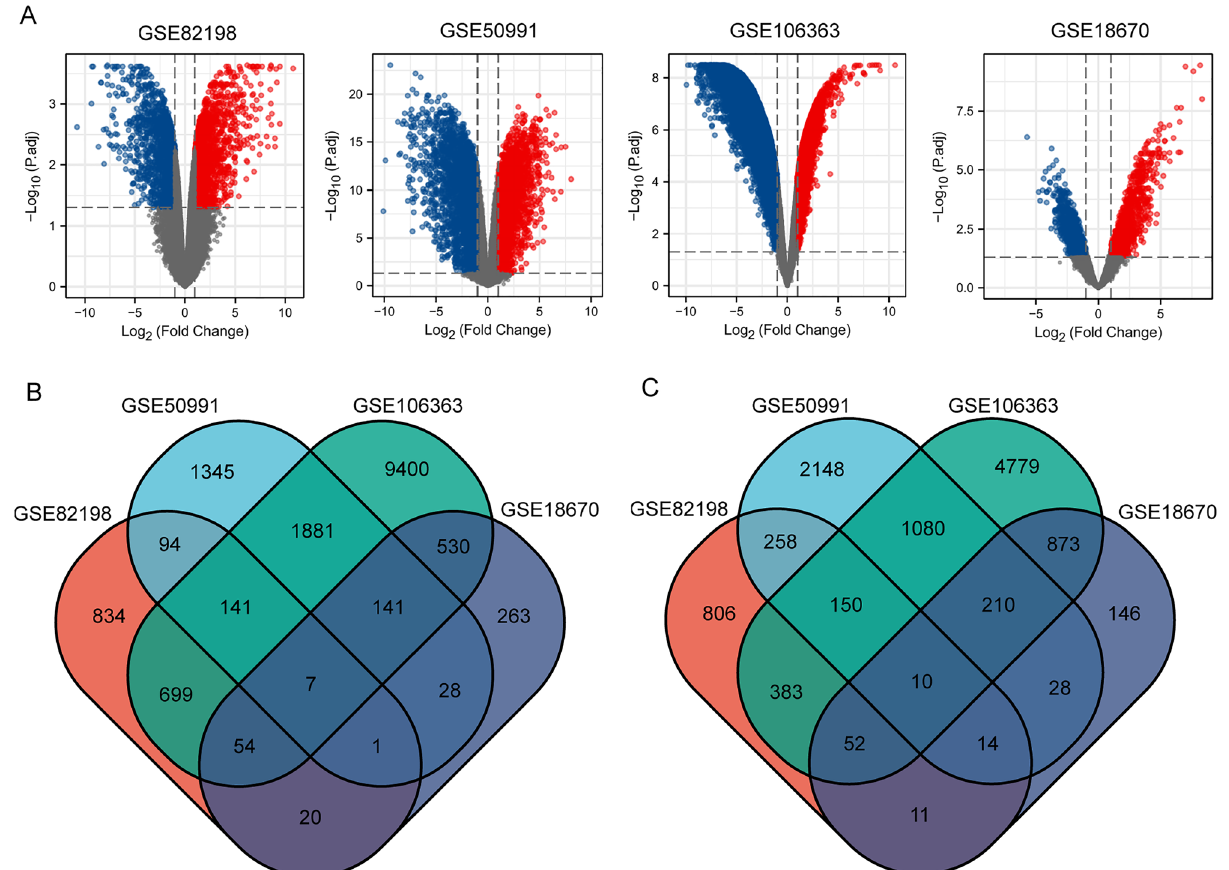
Figure 1. Differentially expressed genes in CTCs. ( A ) Differentially expressed genes in different datasets. ( B ) Venn diagram of up-regulated DEGs in CTCs. ( C ) Venn diagram of down-regulated DEGs in CTCs. The red and blue dots represent up-regulated and down-regulated genes, respectively. The threshold for fold change > 1.0 and a corrected p -value of < 0.05. Black points represent genes with no significant difference. GEO gene expression omnibus, DEGs differentially expressed